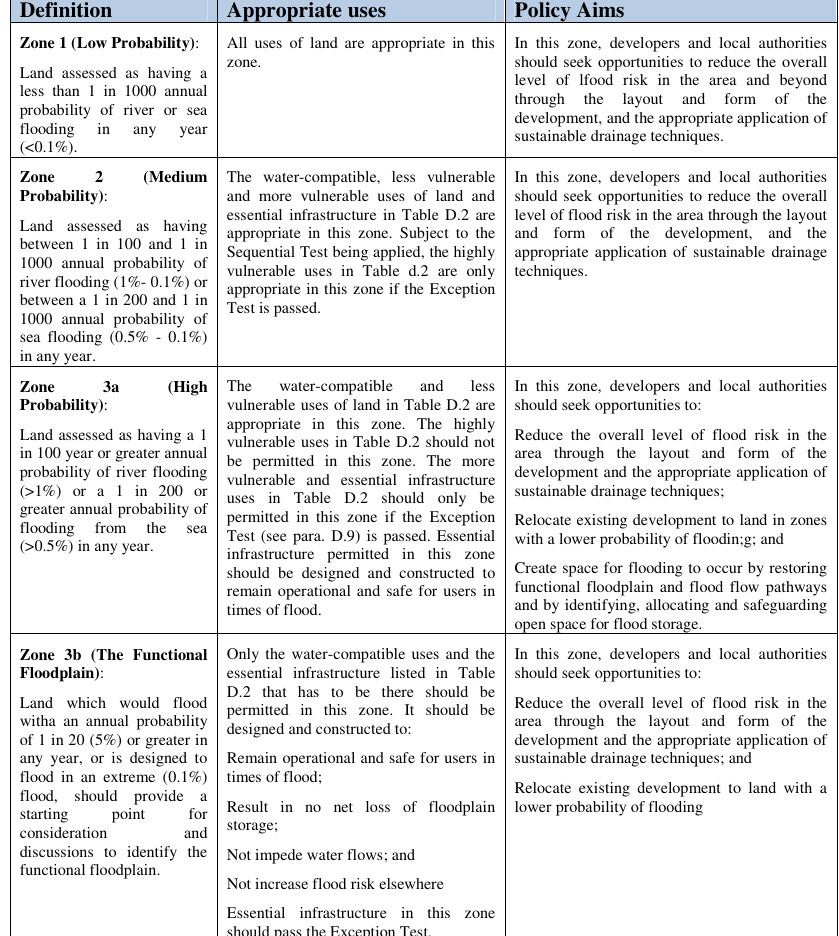
Figure 1. The Sequential Test (from PPS 25, Table D1). 5